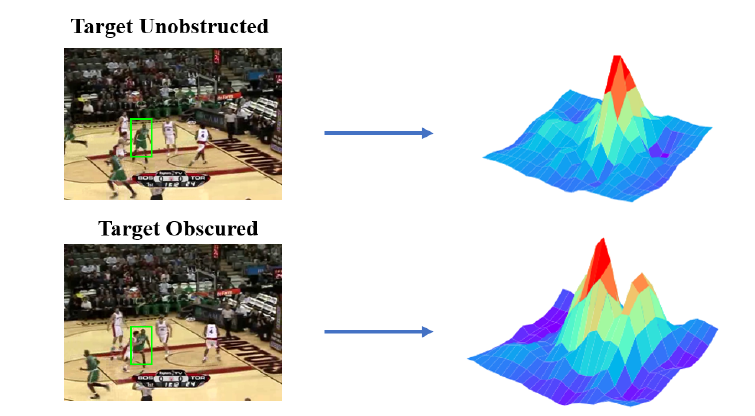
Figure 2. Response map with and without target